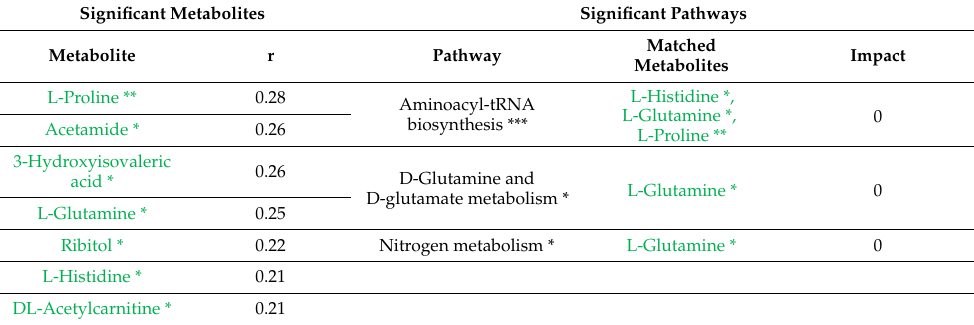
Figure 14. Metabolite-metabolite interaction network for significant metabolites that correlate to adenosine triphosphate-linked respiration, an index of mitochondrial energy production. Size of the node indicates importance in the network. The interaction analysis highlights the importance of citric acid cycle intermediates. PLR correlated with 7 metabolites and mapped to three pathways (Table 17). Three glucogenic amino acids, L-glutamine, L-histidine, and L-proline, were identified in the metabolite-metabolite interaction analysis (Figure 15). Table 17. Metabolites and their pathways which correlate with proton-leak respiration.